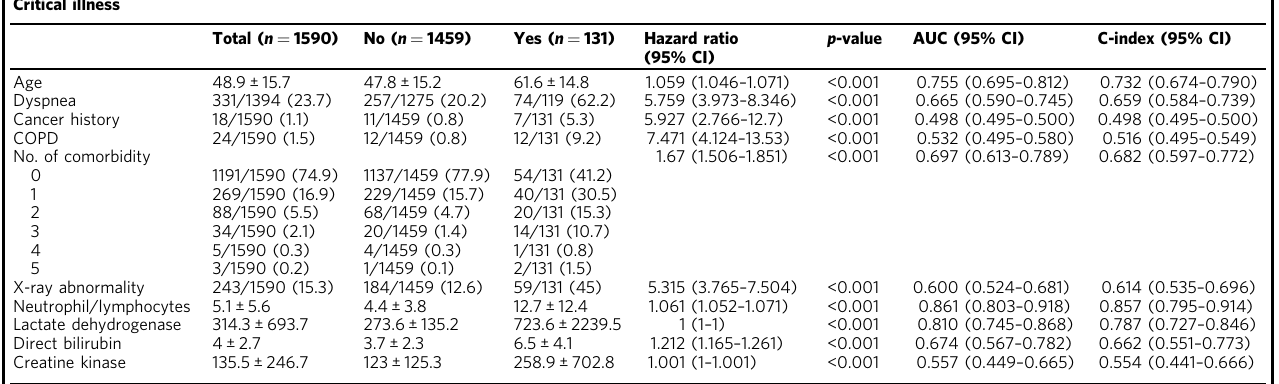
Table 1 Univariate analysis of the selected features for COVID-19 patients in the training cohort. Critical